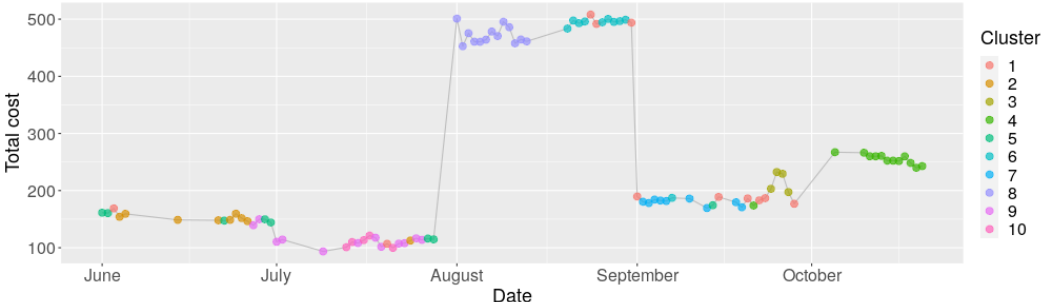
Figure 16. Total cost per day. The vertical axis is the total cost (corresponding to the colors of Figure 15a, while the color of each point is the cluster assignment for each day (corresponding to the colors of Figure 15b. The larger costs appear in August, corresponding to the high-cost